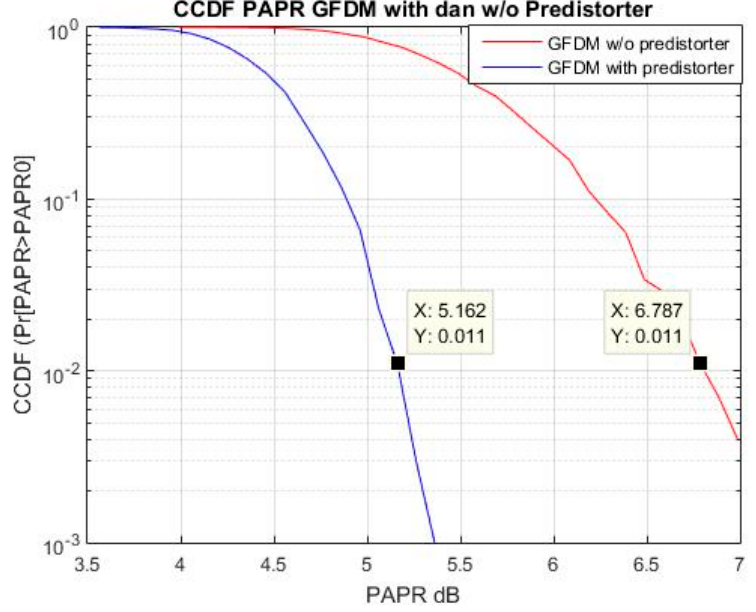
Figure 10. Comparison of PAPR GFDM with and without predistorter (IBO = 3dB).